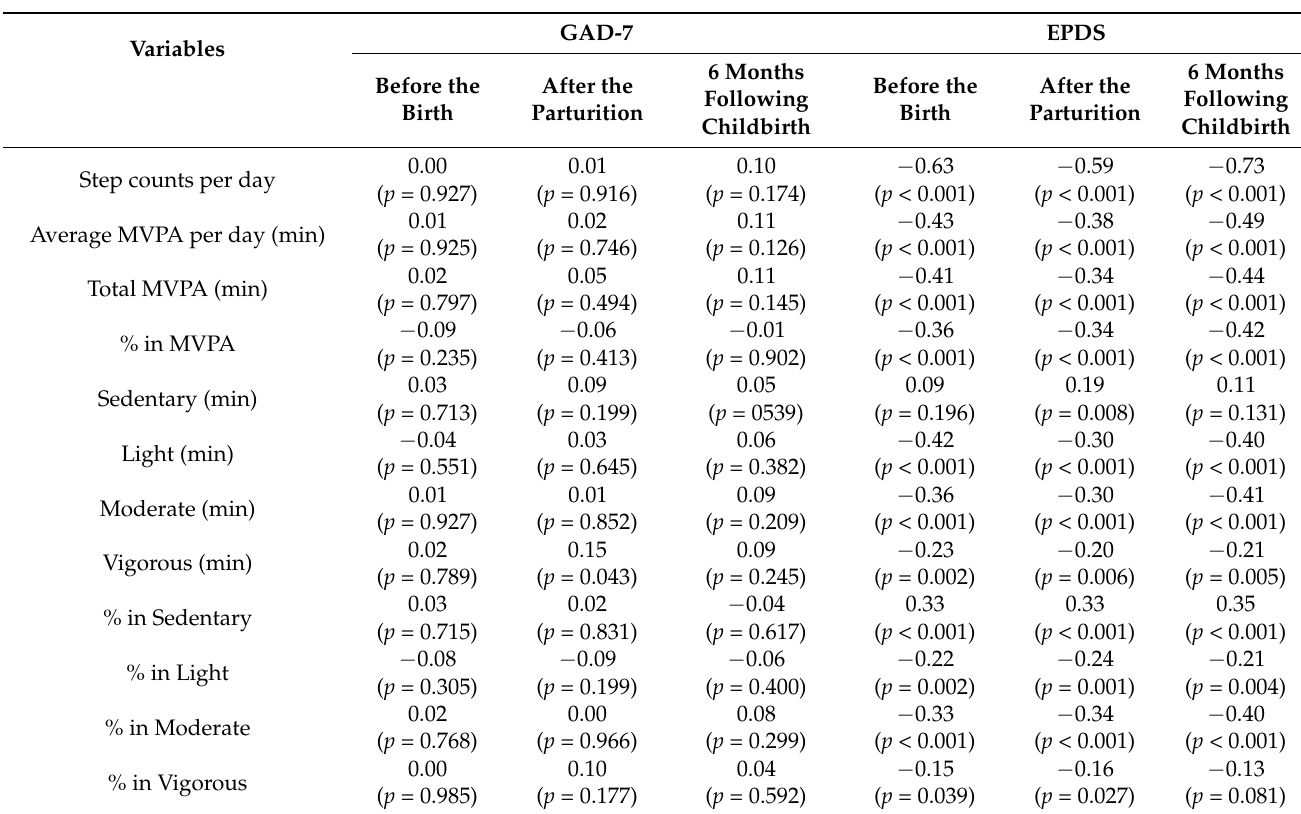
Table 2. Analysis of the correlation of physical activity with the occurrence of anxiety and depression symptoms.